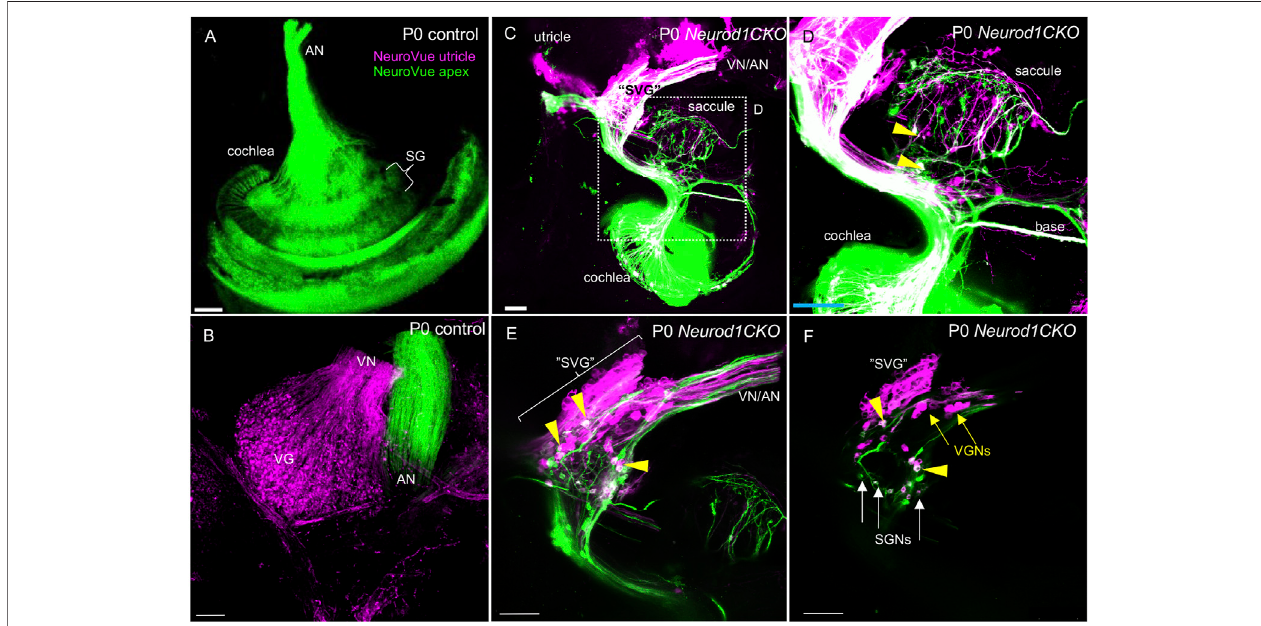
FIGURE6| Unsegregatedinnerearneuronsinterconnectsensoryepitheliaoftheauditoryandvestibularperipheralorgansin Neurod1CKO . (A , B) ANeuroVuedye labeling from the utricle (magenta) and apex (green) shows restricted labeling in the cochlea, auditory nerve (AN), and vestibular ganglion neurons in the vestibular ganglionofcontrolmice. (C , D) Asimilardyeapplicationshowsauniquepatternofdouble-labeledbilateralprojectionstoreachsaccule,base,andapexin Neurod1CKO . Note double-labeled neurons (arrowheads). (E) A larger magni fi cation image shows the aberrant “ spiro-vestibular ” ganglion ( “ SVG ” ) containing a mix of neurons labeled by dyes applied to the apex and utricle in Neurod1CKO . Arrowheads indicate double labeled neurons with projections reaching the utricle and cochlear apex. Note unsegregated axons of vestibular and auditory neurons. (F) Arepresentative one z-stack image of “ SVG ” shows aclutterof larger-size vestibular ganglionneurons (VGNs, arrows) with smaller-size cochlear neurons (SGNs, arrows), and double-labeled neurons (arrowheads). Scale bars: 100 µm. SG, spiral ganglion; SGNs, spiral ganglion neurons; VG, vestibular ganglion; VN, vestibular nerve.